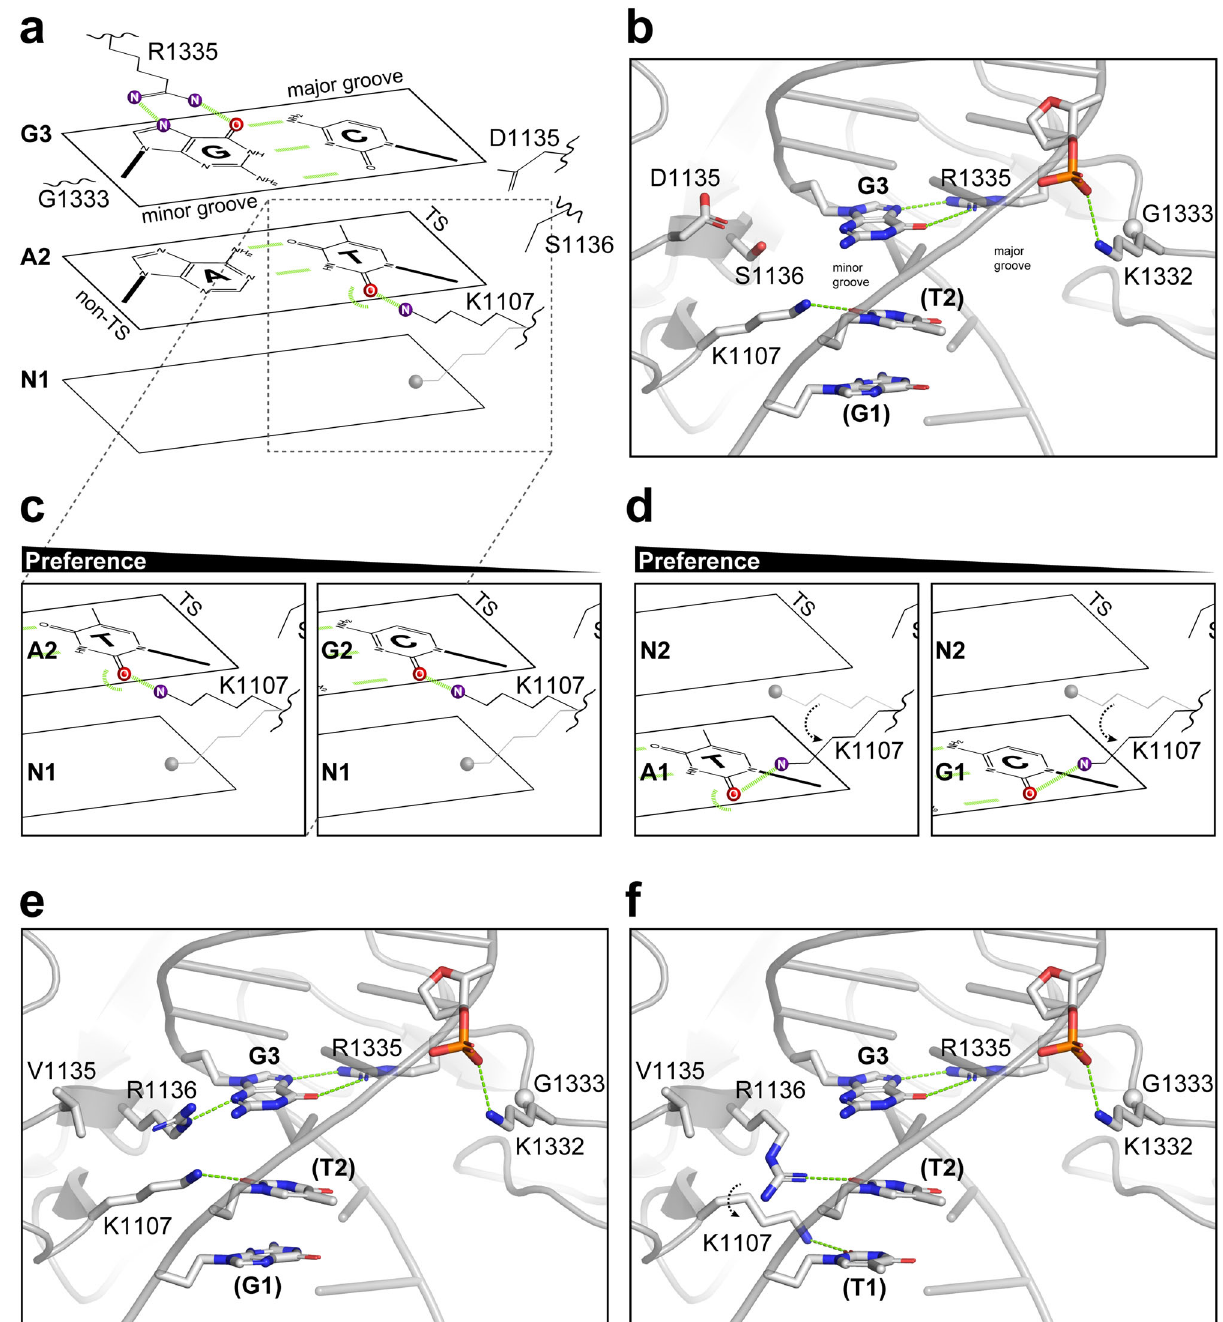
Fig. 6 Molecular modeling of the KG and VRKG variants ’ altered PAM recognition. a Schematic summary of the KG variant ’ s base-speci fi c interactions with a NAG PAM. Major-groove interactions between R1335 and the non-target strand (non-TS) are maintained, as is the minor-groove interaction between K1107 and the target strand (TS). b Three-dimensional model of the KG variant ’ s PID interactions with a CAG PAM, based on a published crystal structure of PAM-bound Cas9 55 (PDB 5F9R). Relevant target strand nucleobases are labeled in parentheses. The D1332K, R1333G, (A1) → (G1), and (C2) → (T2) substitutions were introduced with PyMOL for visualization purposes. One of several K1332 rotamers in range for contacting the phosphate backbone is shown (dashed green line). c Schematics as in panel a , but focusing on K1107 ’ s minor-groove interaction with the O2 acceptor of a TS pyrimidine (boxed inset, dashed gray lines). Thymine harbors more free electrons (curved dashed green line) at its O2 acceptor than cytosine when they are Watson – Crick paired in duplex DNA. d Schematics as in panel c , but summarizing a putative alternative interaction between K1107 and either (T1) or (C1) nucleobases at position 1 of the TS. e Three-dimensional model as in panel b , but for the VRKG variant. R1136 is in range for contacting G3 ’ s acceptor group in the minor groove, without clashing with K1107. f Three-dimensional model as in panel e , but with an AAG PAM. When the alternative K1107 rotamer is adopted, R1136 may also adopt an alternative rotamer in range for minor-groove contacts with (T2) of the